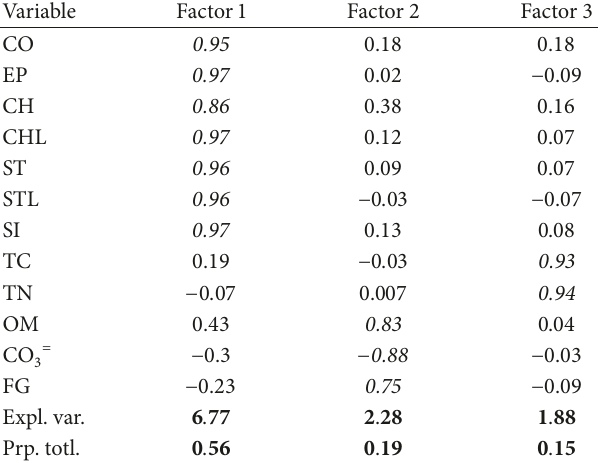
Table 4: Factor analysis for the dry season (May 2013). Significant values are in italic. CO: coprostanol; EP: epicoprostanol; CH: cholesterol; CHL: cholestanol; ST: stigmastanol; STL: